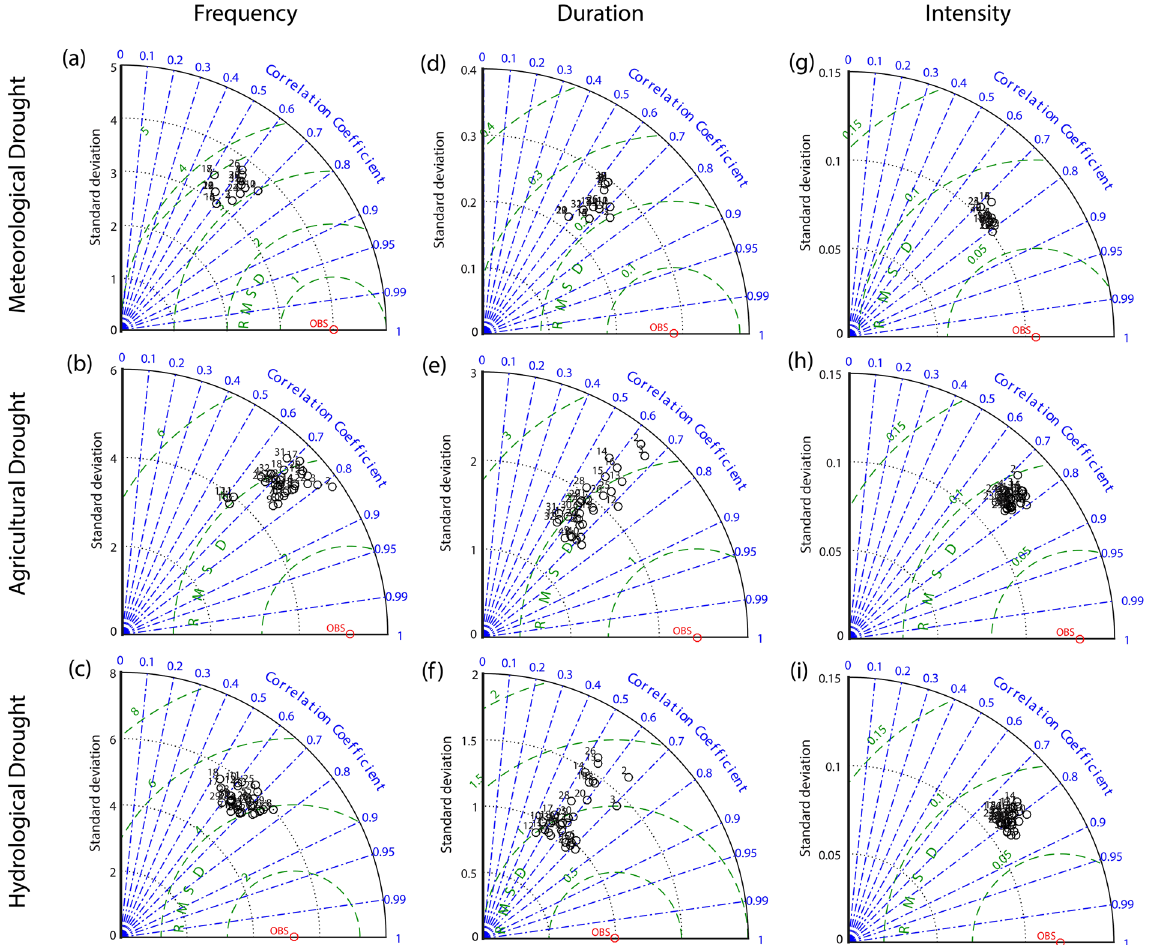
Figure 2. Taylor-diagram on the performance of CMIP5-VIC simulations in reproducing the frequency, duration and intensity of meteorological, agricultural and hydrological droughts by OBS-VIC during 1971–2000. The CMIP5-VIC refers to the bias-corrected CMIP5 climate and VIC simulations driven by bias- corrected CMIP5 climate. Black circles denote the simulations driven by CMIP5-VIC combinations with the numbers indicating the simulations driven by the climate model identified by the ID numbers in Table S1. Figure was created using software MATLAB 2015a